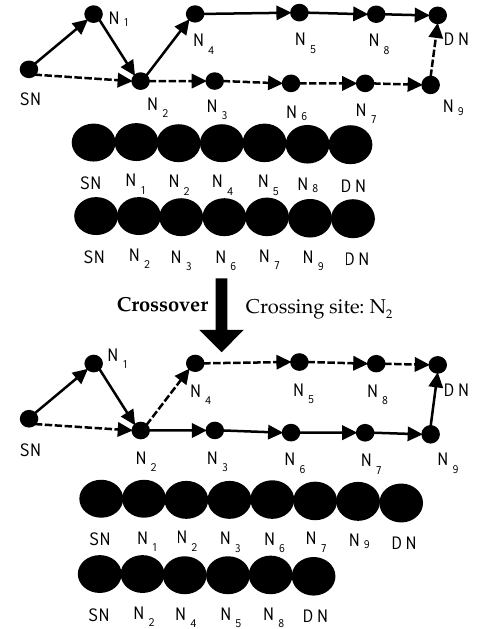
Figure 3. The single-point crossover procedure.